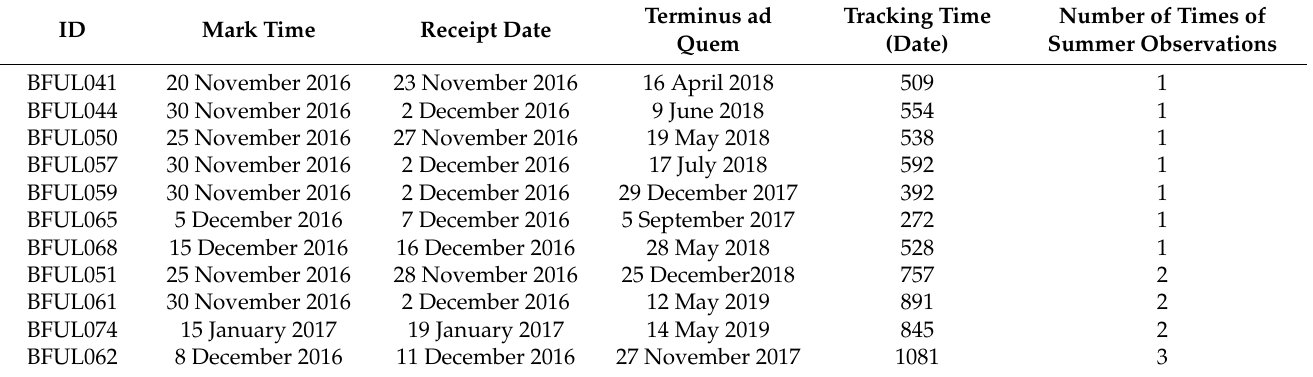
Table 1. Summary of 11 tagged lesser white-fronted geese used for this study (including the wintering, summer, and migration